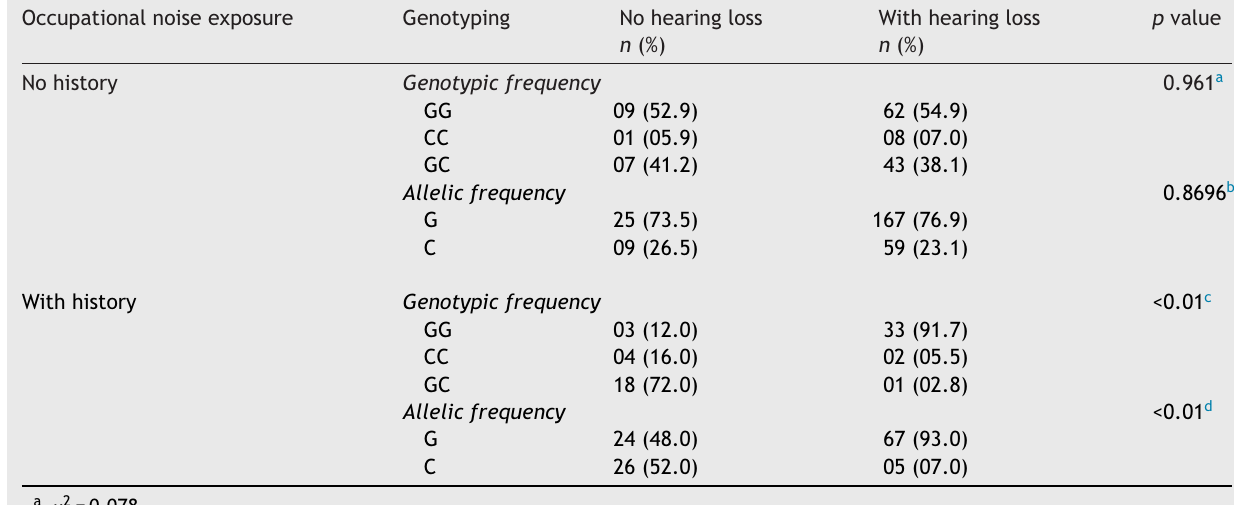
Association between genotype frequency for the interleukin-6 G-174C gene polymorphism and hearing loss related to history of occupational noise exposure ( n =